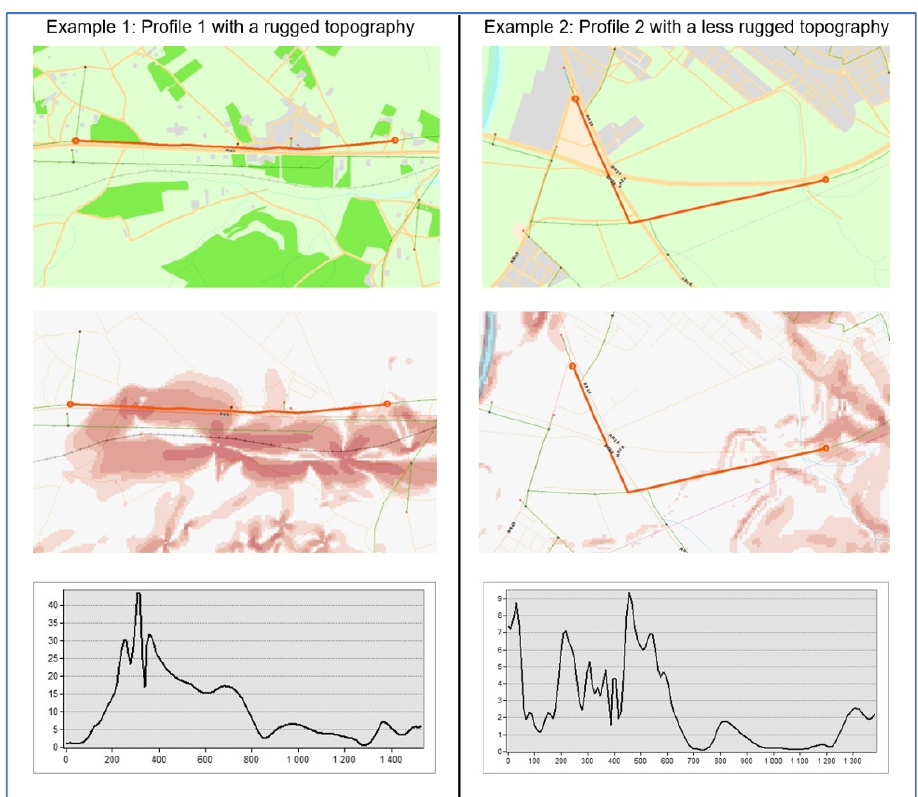
Figure 14. The two profiles used as examples to show the variation of time and speed according to slope.